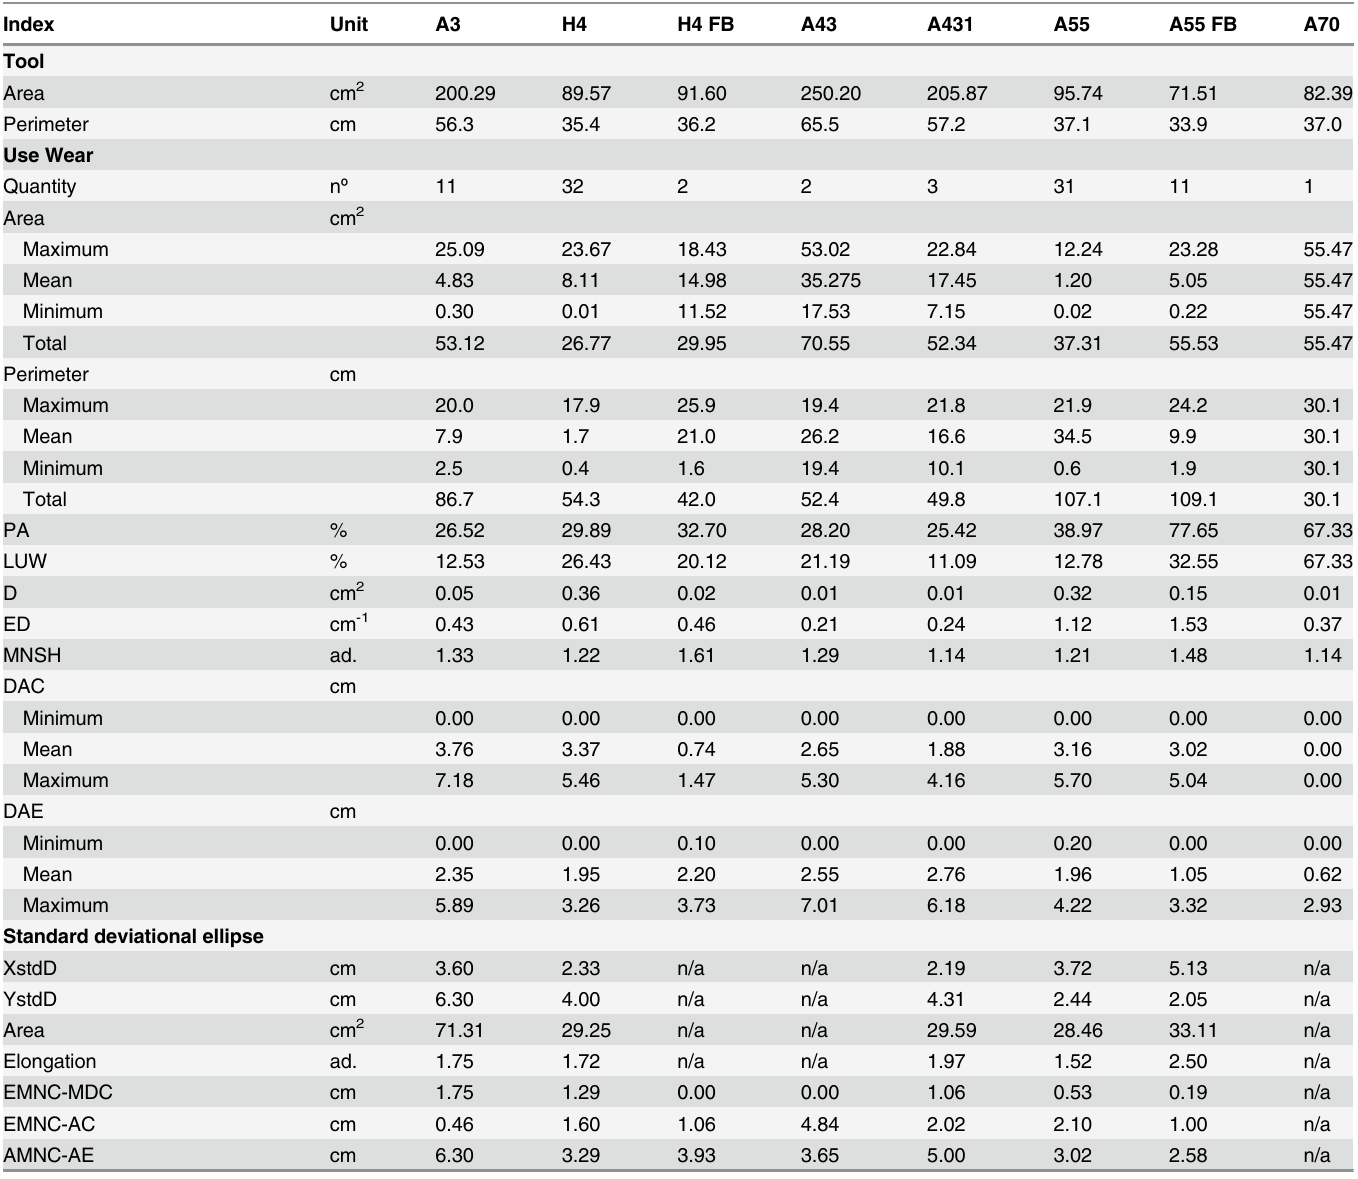
Table 4. Indices used to characterize the spatial pattern distribution of use wears identi fi ed visually, following GIS protocols outlined by de la Torre et al